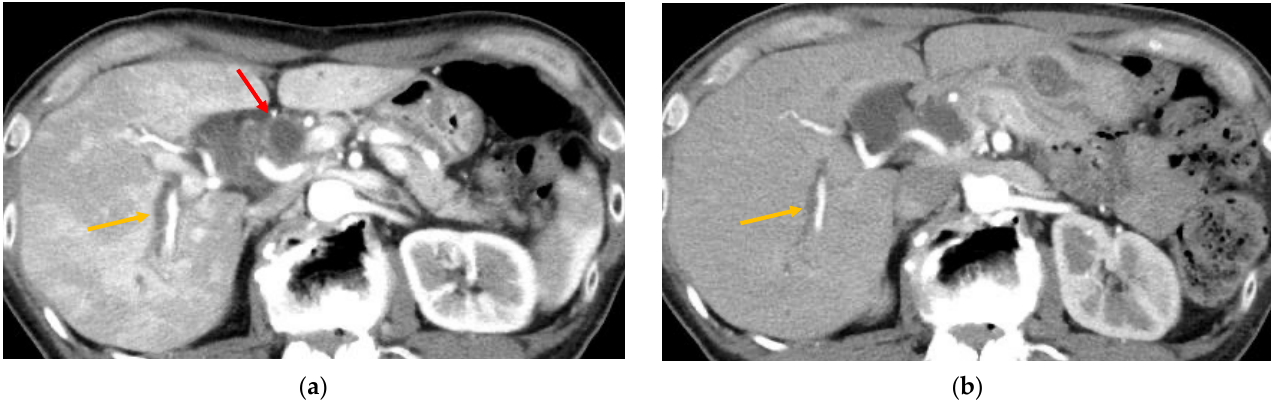
Figure 2. Contrast-enhanced computed tomography (CT) findings of immune checkpoint inhibitor (ICI)-related cholangitis. ( a ) In the arterial phase, the liver parenchyma is irregularly enhanced. Wall thickening of the extrahepatic bile duct (red, arrowhead) and dilatation of the intrahepatic bile ducts (orange, arrowhead) were also observed. ( b ) After starting steroid therapy, the irregularly enhanced hepatic parenchyma showed a marked improvement. Intrahepatic bile duct dilatation remained but gradually improved (orange,